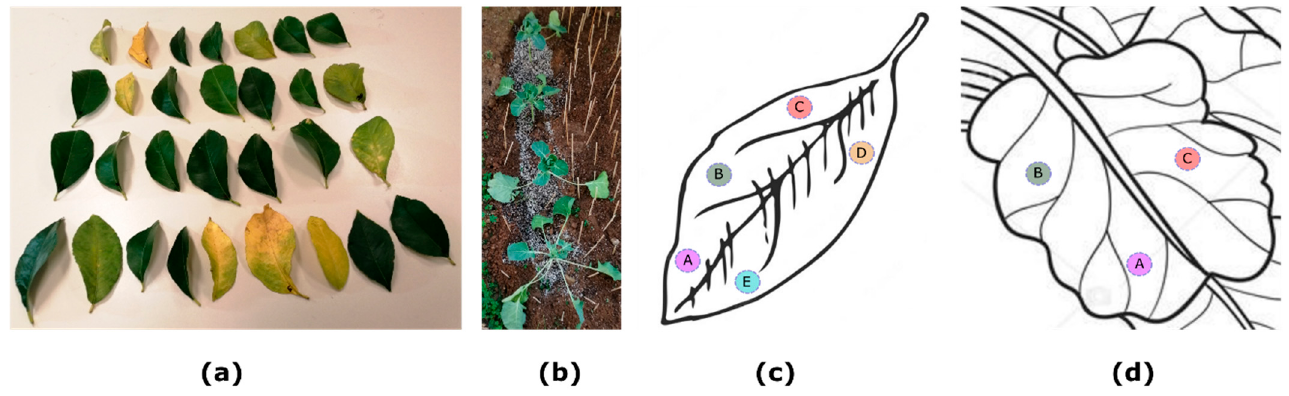
Figure 6. In ( a ), the 30 lemon leaves samples of experiment 1 are shown, selected to span a wide range of color shades (slightly yellow to dark green). In ( b ), a snapshot of some of the young Brussels sprouts growing in an experimental garden that were used for the measurements referred to in experiment 2. The chlorophyll meter measurements were all performed on-site, using all sensors and trying to avoid the major veins and to reach the leaf areas marked with the letters A to E in Figure ( c ) and A to C in Figure ( d ), in most cases. In each of these areas, 5 measurements were acquired, and the values were averaged prior to model fitting. The samples in ( a ) were collected to be photographed after being measured on-site.